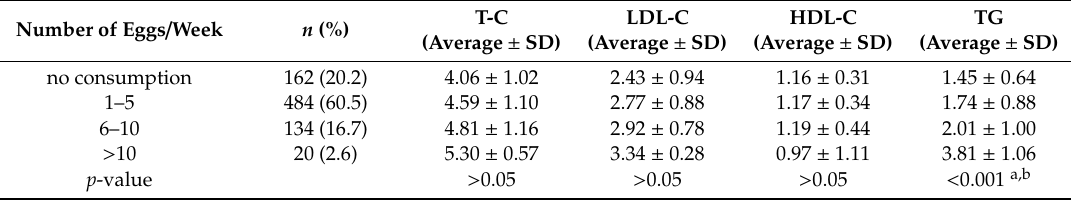
Table 5. E ff ect of consumption of eggs on lipid profile (mmol /